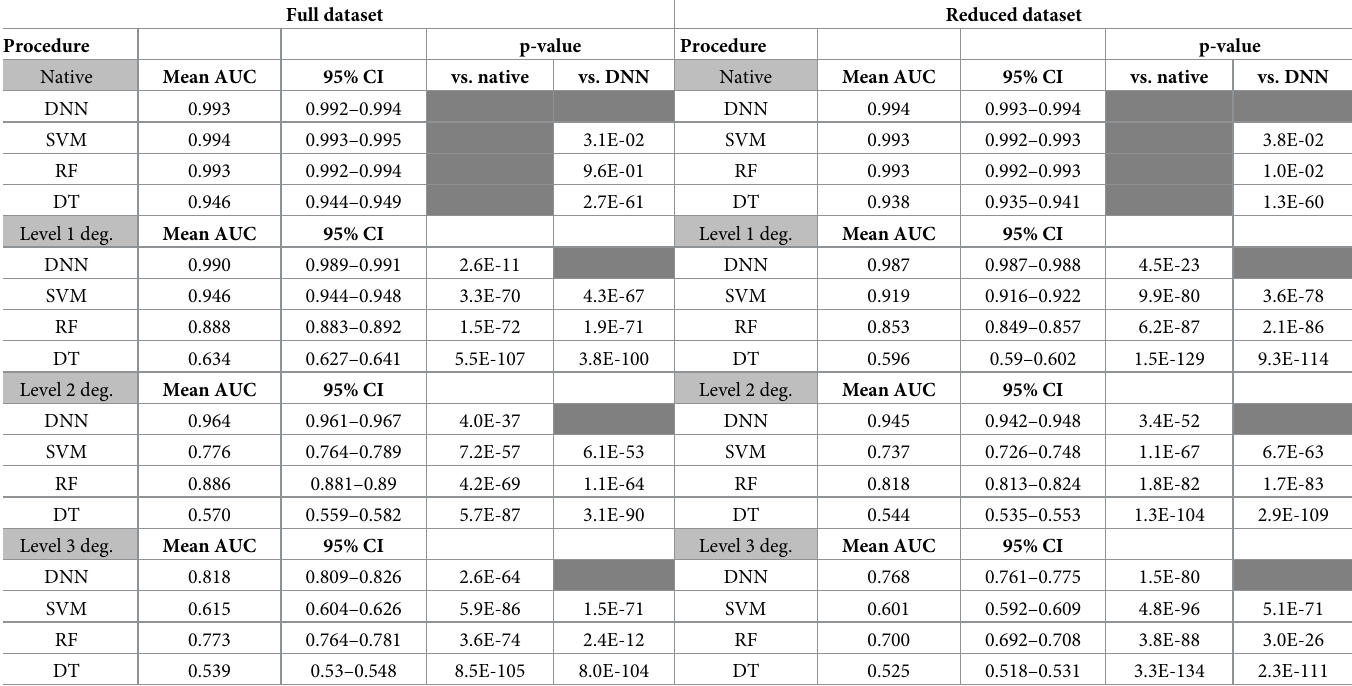
Table 1. Detailed comparison of diagnostic performance (by AUC) for investigated machine-learning classifiers.